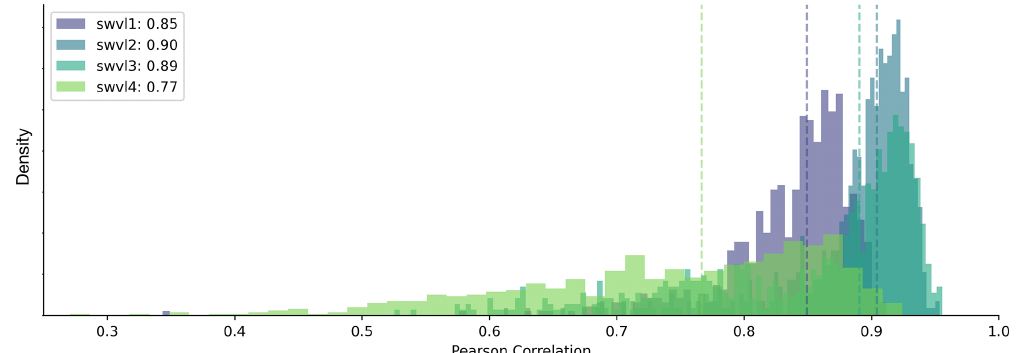
Figure 2. Histogram of catchment correlation scores for each soil water volume level: soil water volume level 1 (swvl1) contains soil moisture from depths of 0–7cm, soil water volume level 2 (swvl2) contains soil moisture from depths of 7–28cm, soil water volume level 3 (swvl3) contains soil moisture from depths of 28–100cm, and soil water volume level 4 (swvl4) contains soil moisture from depths of